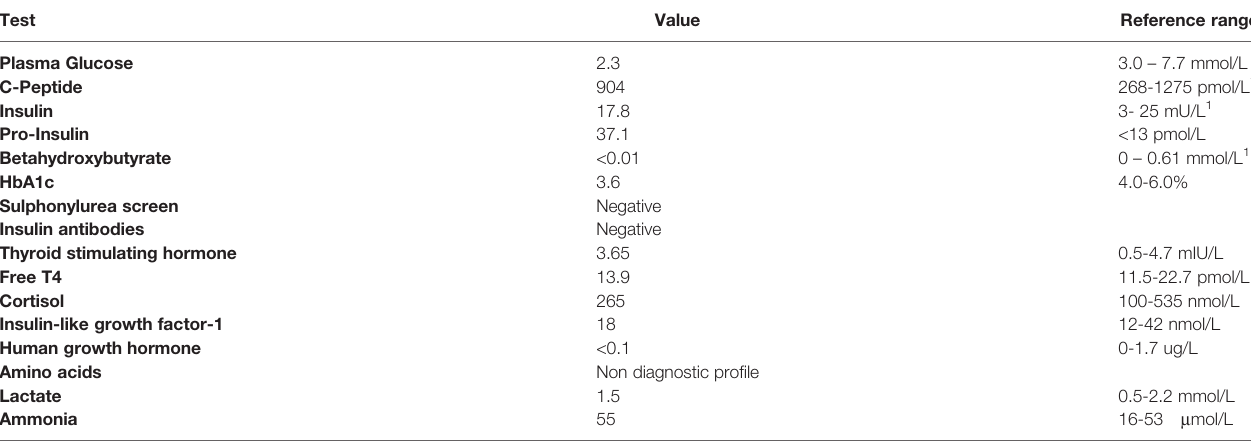
TABLE 1 | Initial biochemical parameters*.